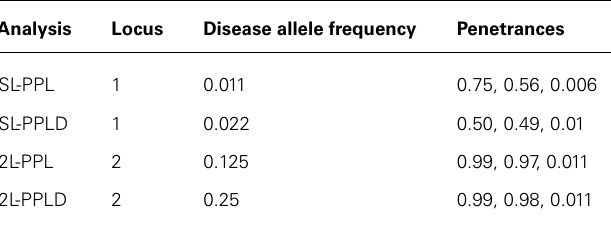
Table 2 |Approximate maximum likelihood trait parameter estimates.